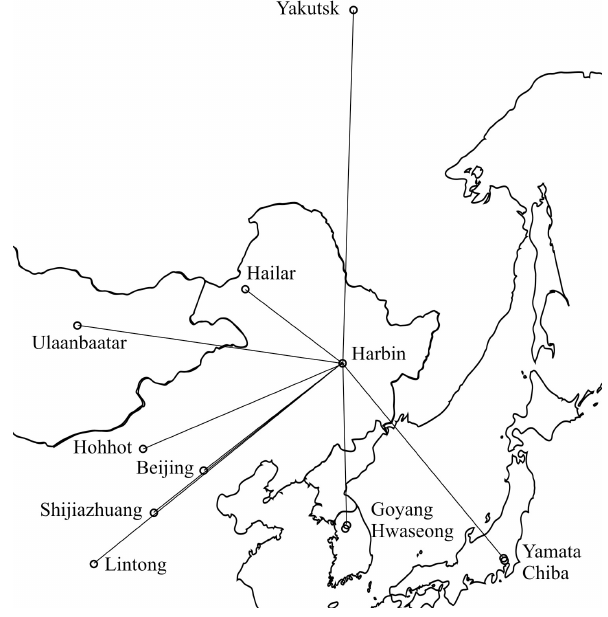
Figure 1. Layout of the propagation paths used for monitoring dy- namic processes acting in the